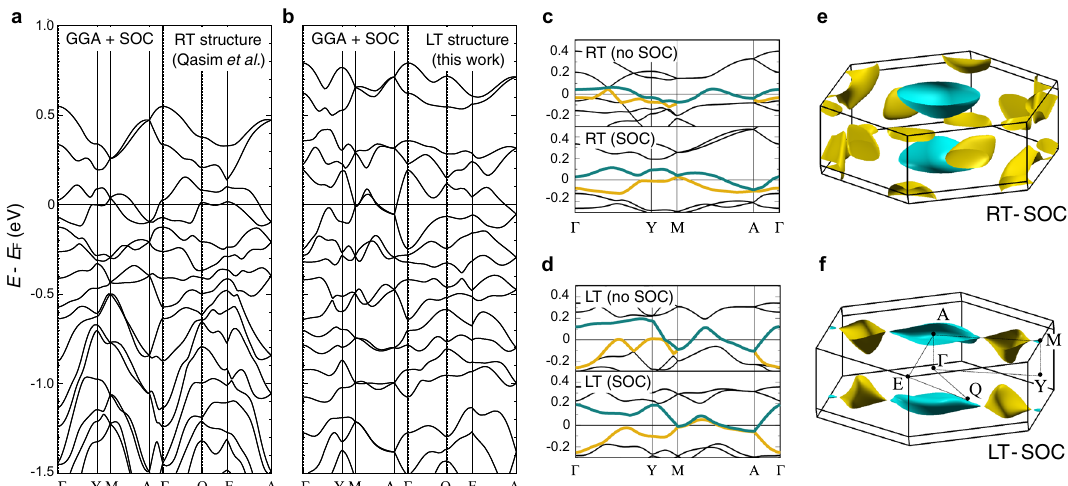
Fig. 2 Electronic structure of m -SIO 3 calculated by density-functional theory. a, b Band structures obtained using room-temperature (RT) lattice parameters reported in 27 and low-temperature (LT) lattice parameters found at 13 K on our crystals. The high-symmetry points in the fi rst Brillouin zone are labelled in f . c, d Comparison of the RT and LT band structures with and without SOC near the Fermi energy ϵ that give rise to electron and hole Fermi pockets are highlighted in cyan and yellow, respectively. Note that linear band-crossings at the M- and A-points are found in both GGA + SOC results despite the overall differences. e, f Corresponding Fermi surface models for the RT and LT band structures (GGA + SOC). Fermi pockets are colour-coded in accordance with c, d .